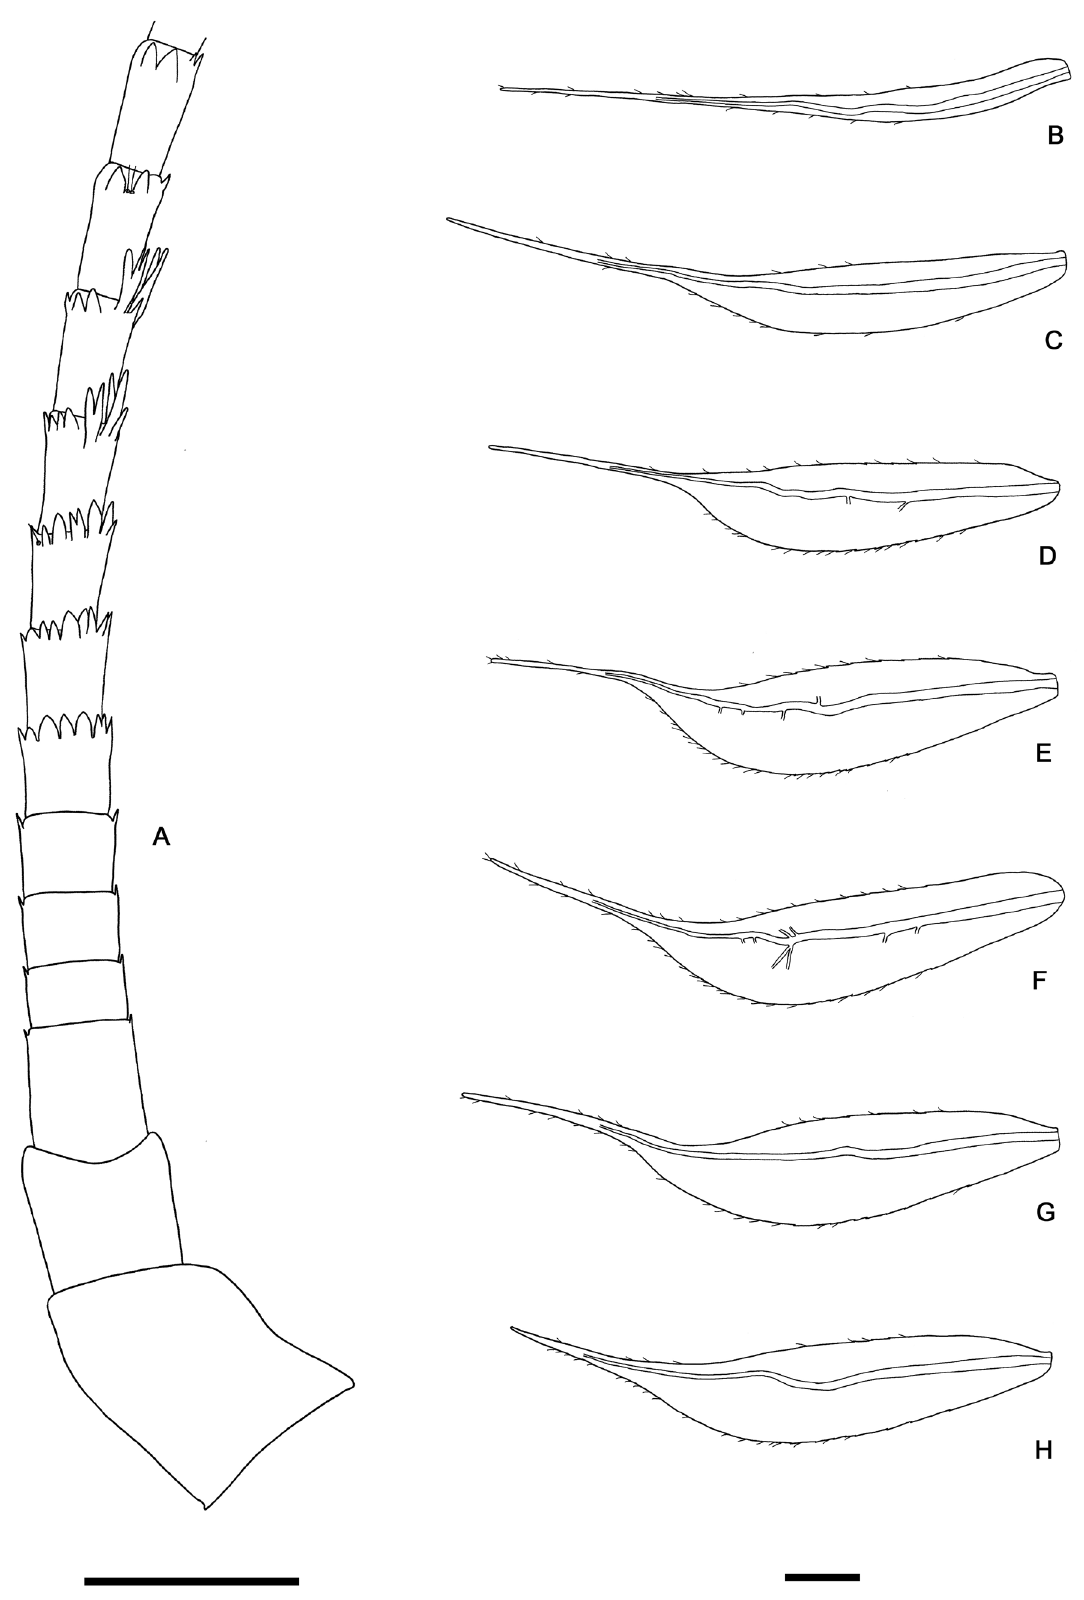
Fig. 10. Procerobaetis freitagi gen. et sp. nov., larval morphology. A . Antenna. B . Gill I. C . Gill II. D . Gill III. E . Gill IV. F . Gill V. G . Gill VI. H . Gill VII. Scale bars: 0.1